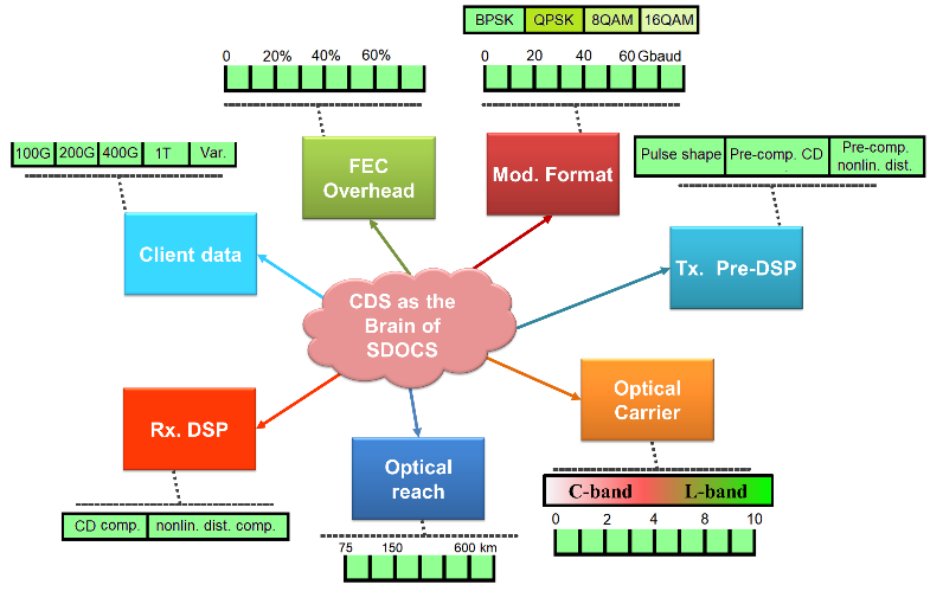
Figure 14. The software defined optical communications system (SDOCS) relies on CDS as its